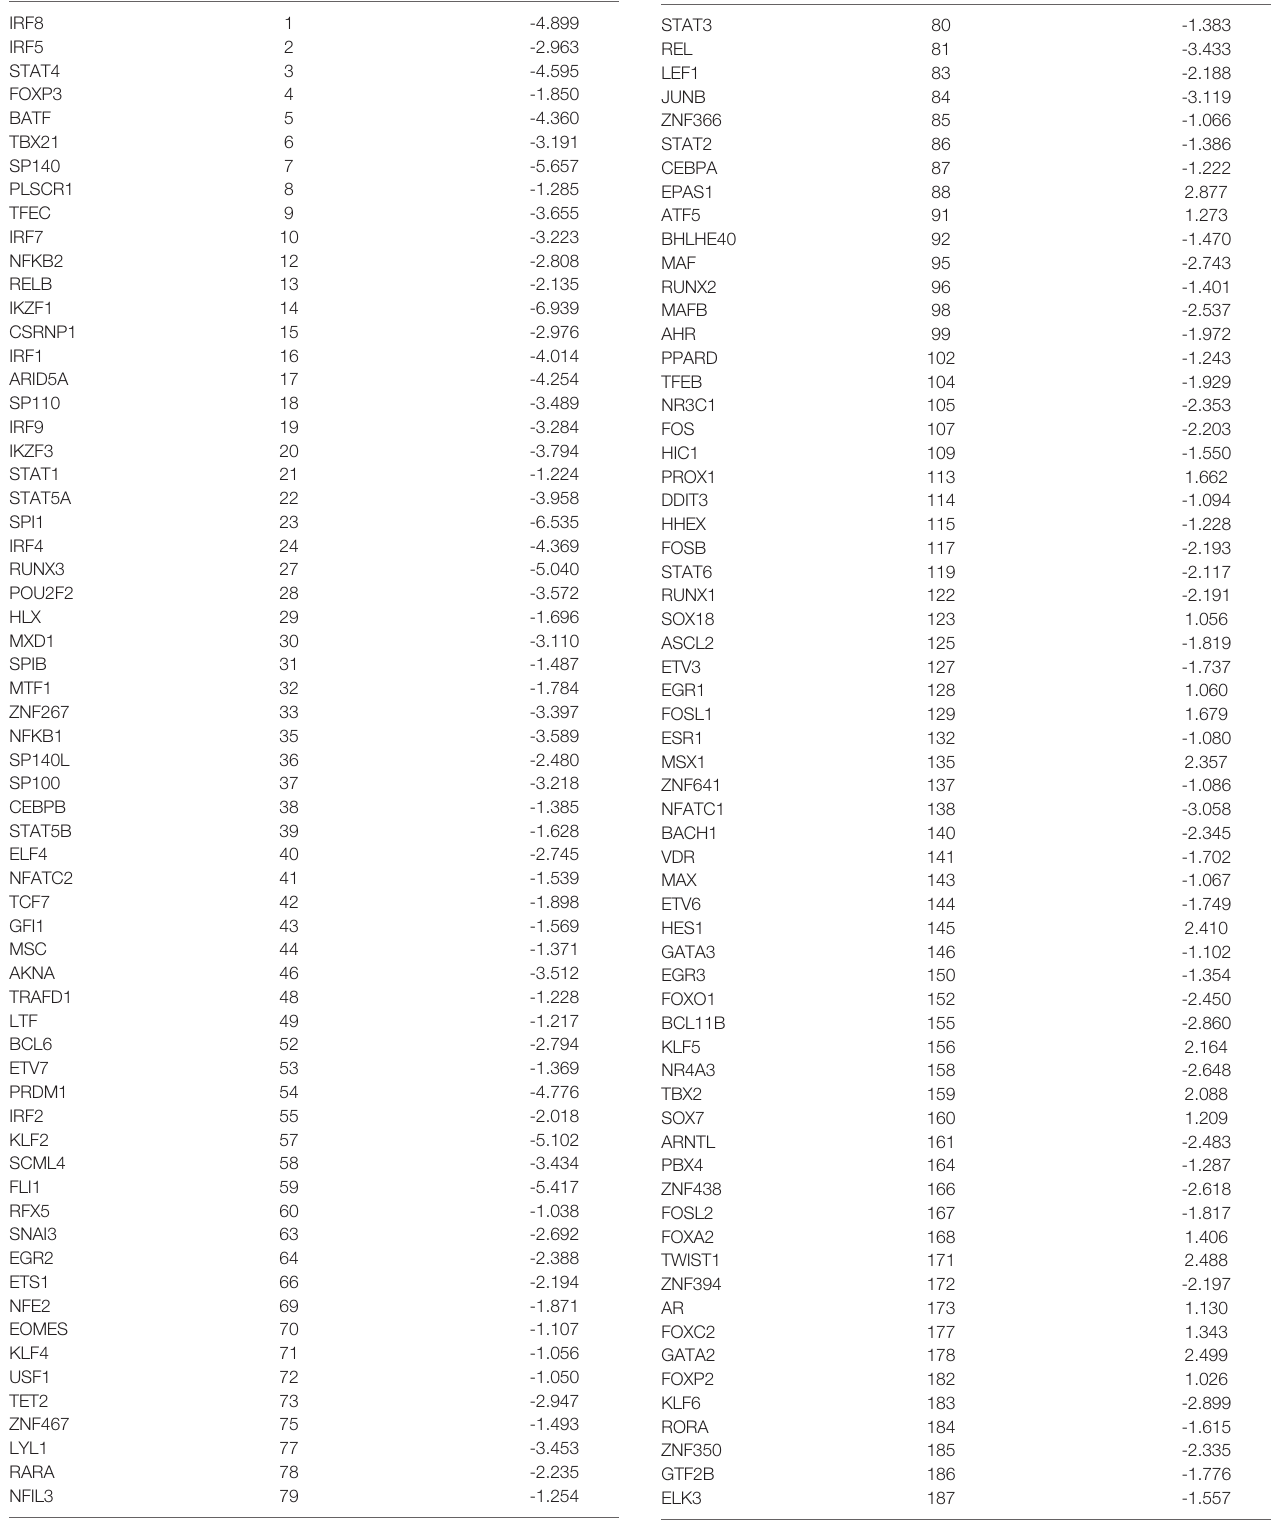
TABLE 3 | List of immune-related transcription factors